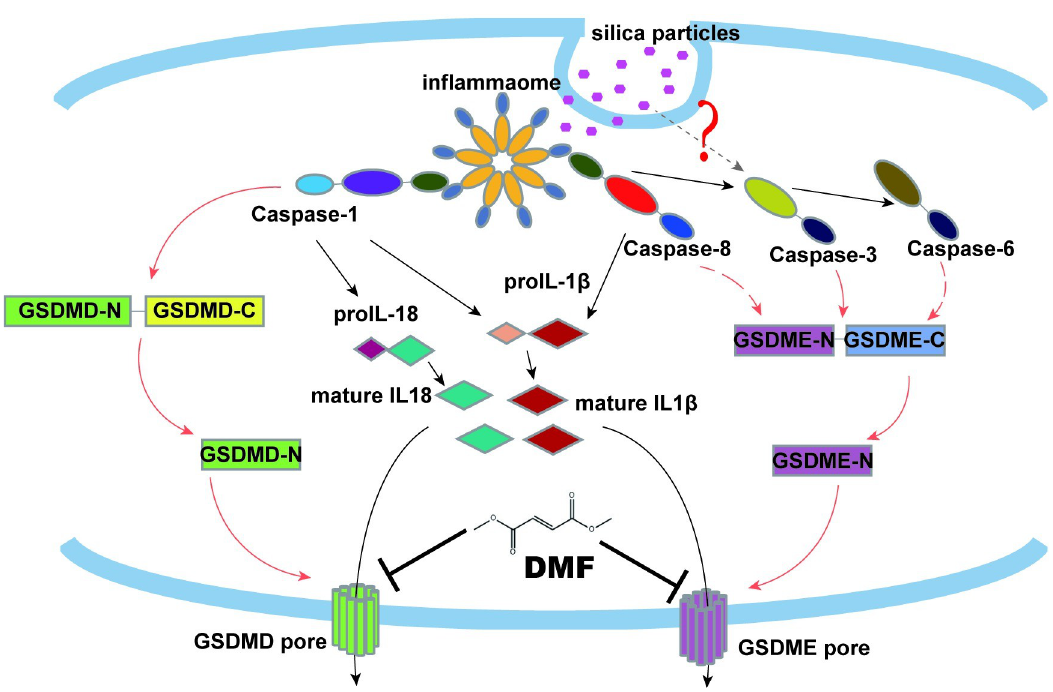
Fig 8. Schematic of silica-induced pyroptosis and